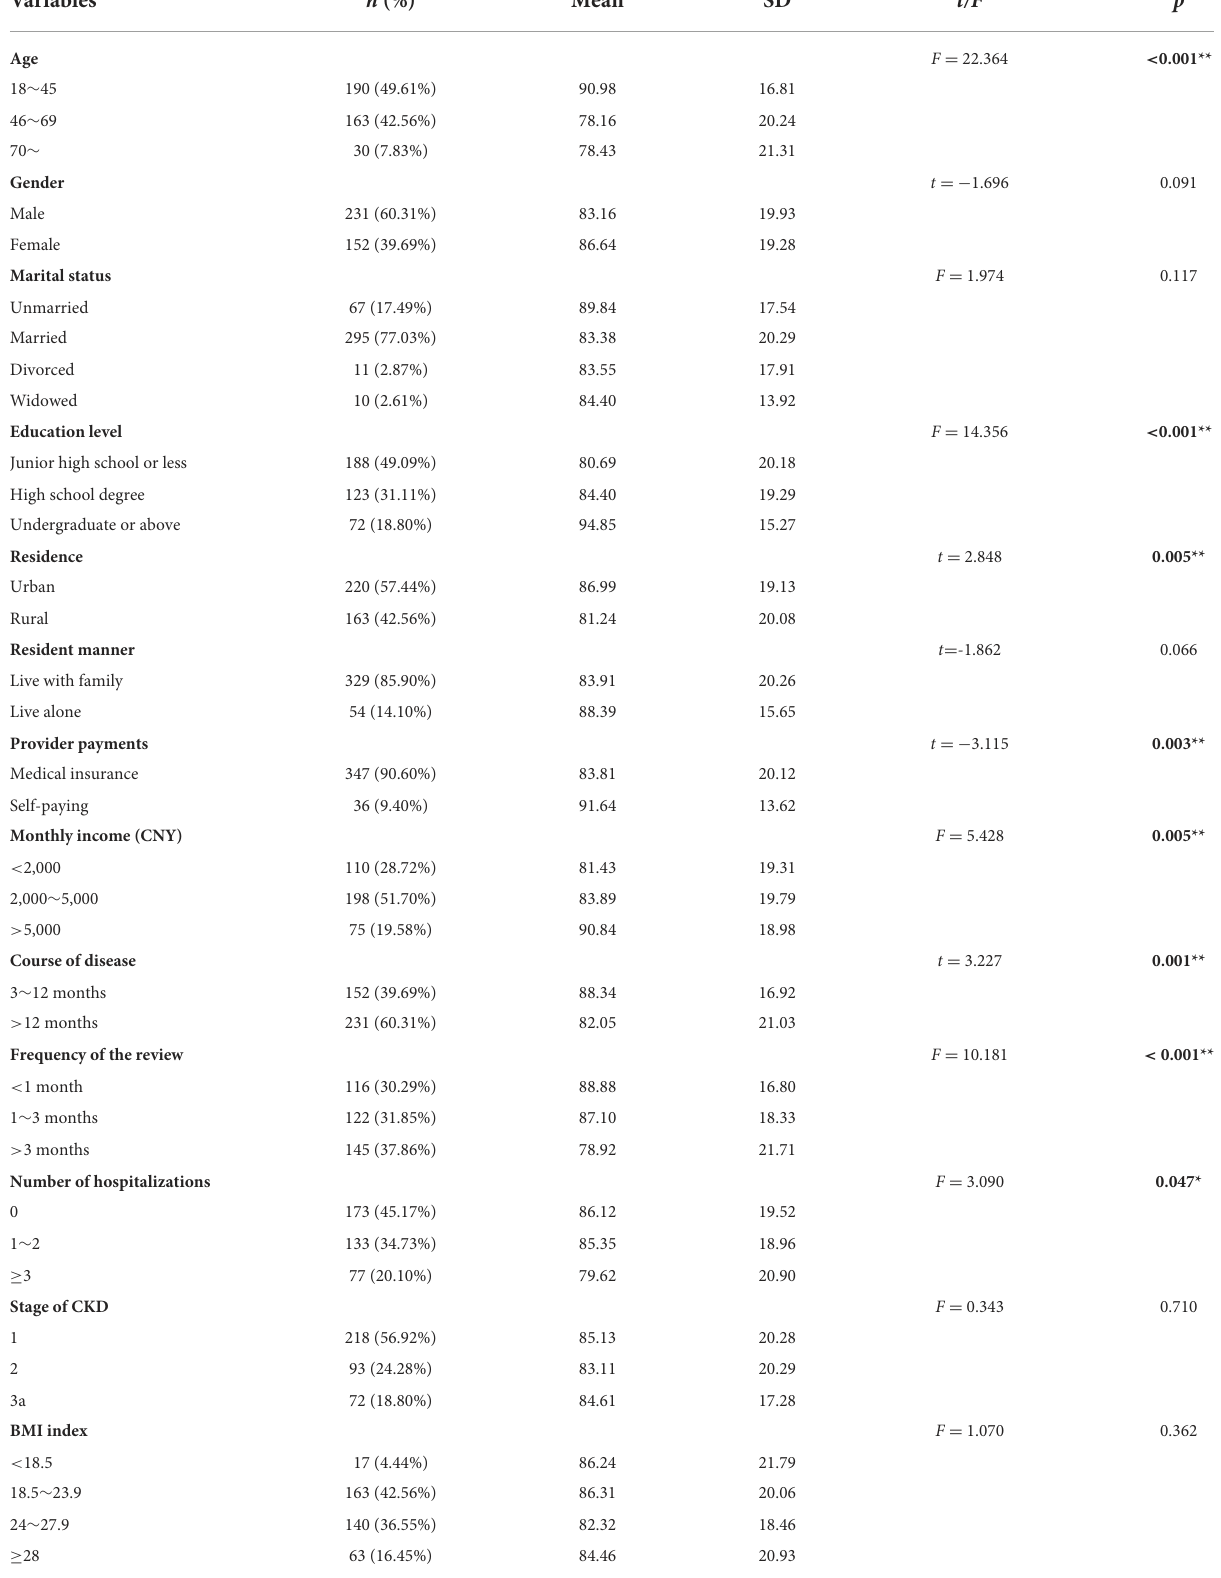
TABLE 1 Sociodemographic characteristics of the participants and the comparison of self-management behavior ( n = 383).